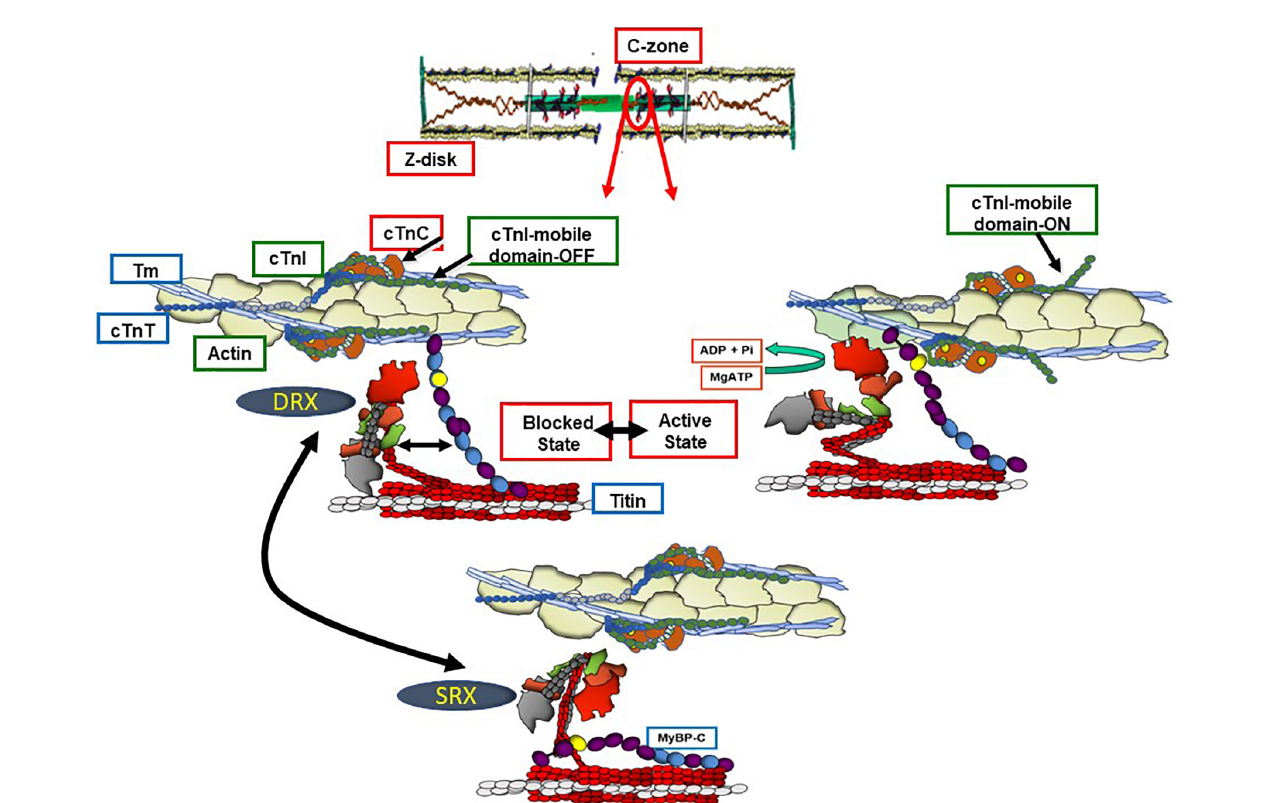
FIGURE1 Functional units of C-zone sarcomeres in relaxed and active states. Shown are functional units of cardiac sarcomeres in the C-zone containing c(MyBP-C). The bottom panel shows a sarcomere the Ca-regulatory site on cTnC not occupied and with myosin in a super relaxed state (SRX) in which the heads are sequestered and not participating in the heartbeat. In the left middle panel , the cross-bridges are in a disordered relaxed state (DRX) poised to interact with the thin filament but blocked by the actions of the troponin complex proteins with an inhibitory peptide (Ip) and mobile domain of troponin I (cTnI) locking tropomyosin (Tm) a position sterically blocking the actin-cross-bridge interaction. This blocking position of Tm relies on an interaction of troponin T (cTnT) with the overlap region of Tm. In this state there is an interaction of the N-terminal domain of myosin binding protein C (cMyBP-C) with actin-Tm moving Tm away from it’s steric blocking position. As indicated, there are also interactions between the middle regions of cMyBP-C and myosin producing a drag on shortening capability. The right middle panel shows that with Ca-binding to the N-terminal domain of troponin C (cTnC) the thin filament is released from inhibition permitting activation of cross-bridge interactions with actin promoting force and shortening of sarcomere. The kinetics of the actin-cross-bridge reaction depend on interactions with the N-terminus of cMyBP-C (see text and Figure 2 for